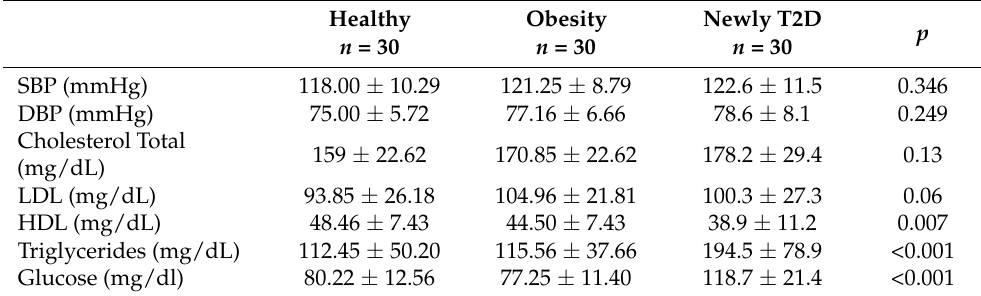
Table 2. Clinical characteristics.